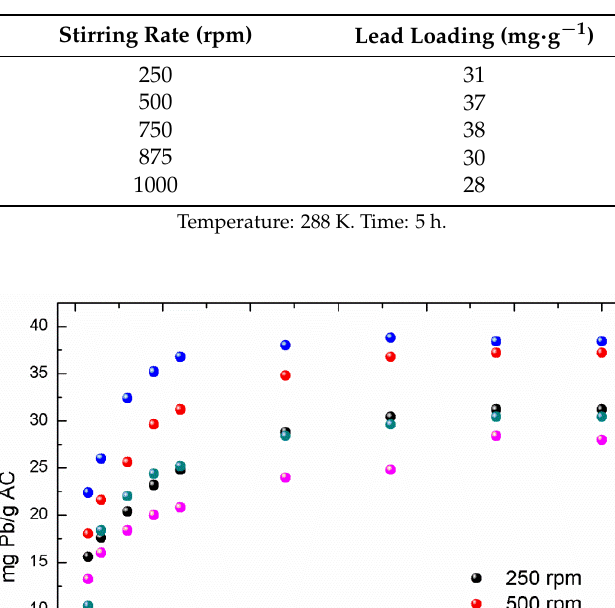
Table 3. Influence of the stirring rate on Pb 2+ loading.